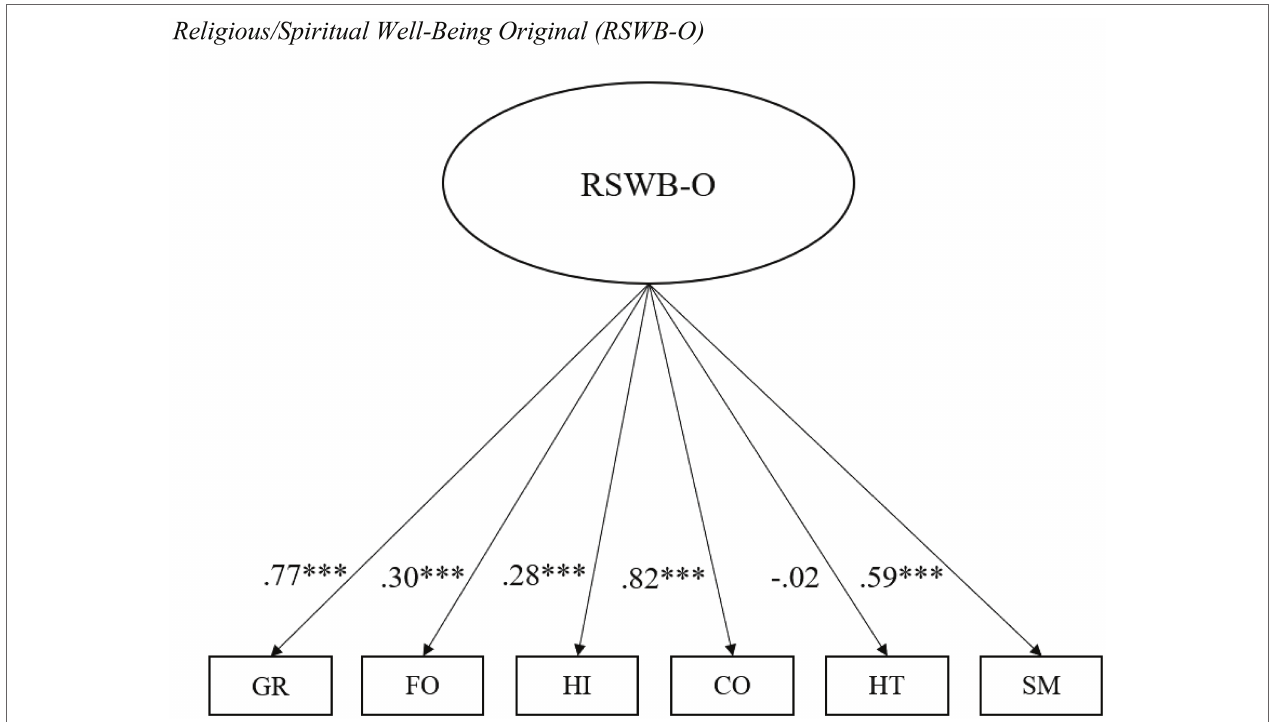
FIGURE 1 | Religious/Spiritual Well-Being (RSWB) Original (RSWB-O). Confirmatory factor analysis ( n = 711). GR, General Religiosity; FO, Forgiveness; HI, Hope Immanent; CO, Connectedness; HT, Hope Transcendent; SM, Experiences of Sense and Meaning; and RSWB-O, Religious/Spiritual Well-Being Original. *** p <